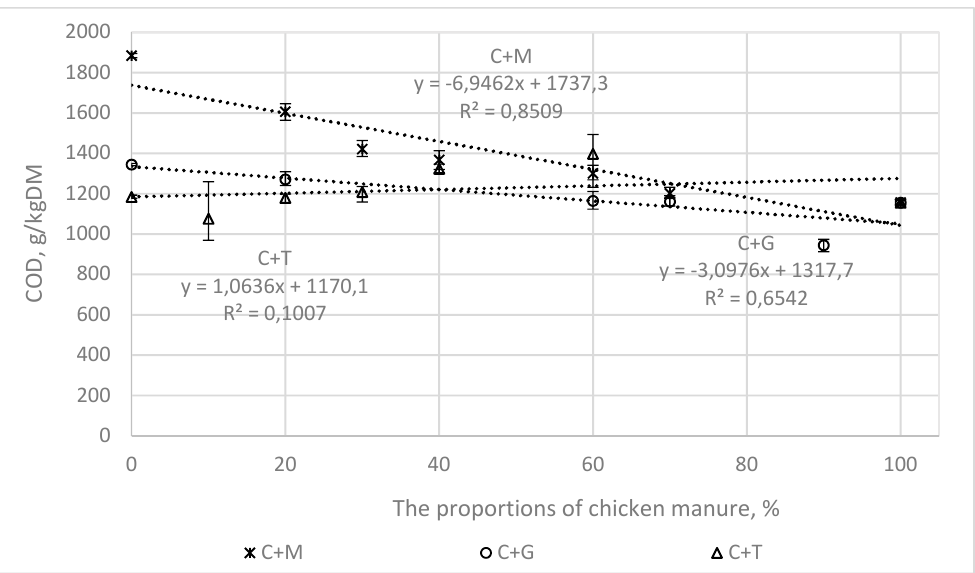
Figure 5. The correlations between COD and the proportions of chicken manure in the mixtures with co-substrates.